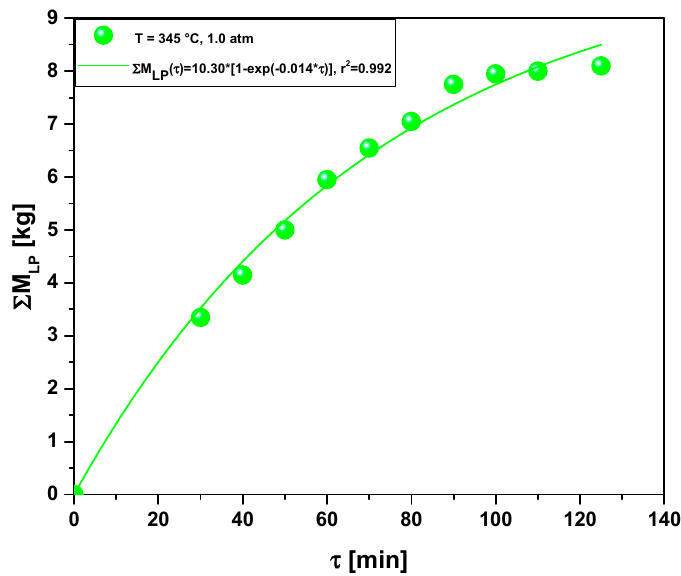
Figure 6. Accumulative mass of liquid products by depolymerization of PMMA based dental resins fragments/residues at 345 °C, 1.0 atm, in pilot scale.